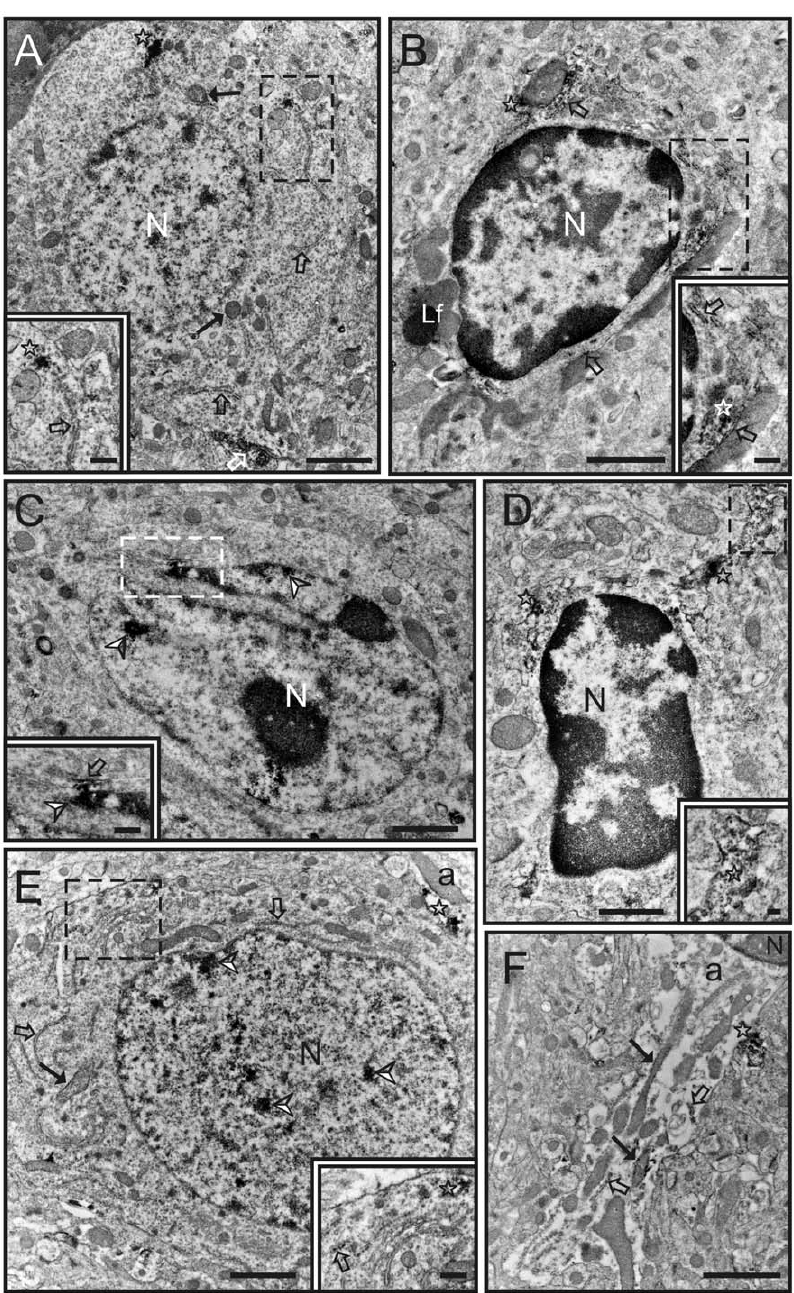
Figure 7. Electron microscopy images of pSer9GSK3 b labeling in cortical and subcortical areas. A) pSer9GSK3 b labeling in a neuron in the piriform cortex. The labeling is located in the rough endoplasmic reticulum (outlined arrows), free ribosomes (stars) and the outer mitochondrial membrane (black arrow). Note the strong staining in a cluster of free ribosomes in A inset . B) pSer9GSK3 b immunolabeling in a microglia cell in the piriform cortex. Staining is present in the rough endoplasmic reticulum (outlined arrows) as well as in free ribosomes (stars). B inset shows a detail of the labeling present in this cell. C) pSer9GSK3 b labeling in another microglia cell in the piriform cortex. In this case labeling is prominently present in the nucleus (arrowheads) while the cytoplasmic labeling is restricted to a small portion of the rough endoplasmic reticulum (outlined arrow). C inset shows a detail of the labeling present in the nucleus (arrowhead) and the rough endoplasmic reticulum (outlined arrow) in the proximity of the outer nuclear membrane. D) pSer9GSK3 b staining in a microglia cell in the striatum. Labeling is prominent in clusters of free ribosomes (stars) in the cytoplasm as well as in the process (see D inset ). E) Photomicrograph of pSer9GSK3 b staining in a neuron in the motor cortex. Note the prominent labeling in the nucleus (arrowheads). Labeling is also present in the rough endoplasmic reticulum (outline arrows, see also E Inset ), as well as in clusters of free ribosomes and in the outer membrane of one mitochondria (black arrow). Note also the presence of an astrocytic process (a) showing immunolabeling in free ribosomes (star). F) Detail of an astrocytic process (a) showing pSer9GSK3 b immunolabeling in rough endoplasmic reticulum (outlined arrow), free ribosomes (star) and mitochondria (black arrows). [Lf: Lipofuscin body; N: nucleus; Scale bars: 1 m m in A–C, E; 0.5 m m in D; 0.25 m m in B inset, C inset; 0.1 m m in D inset]